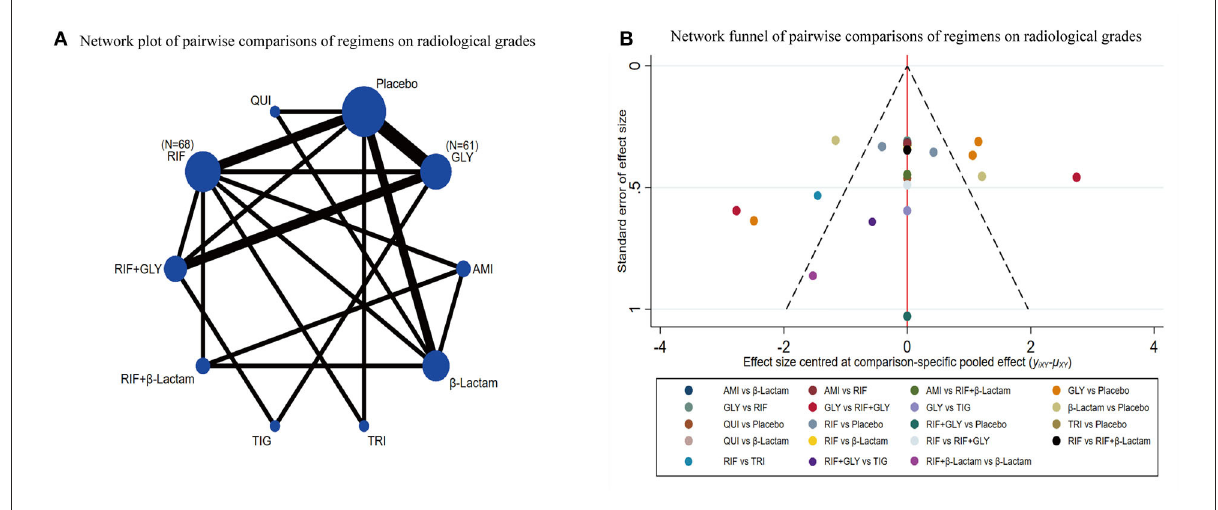
Figure 3A. RIF and GLY had the highest number of